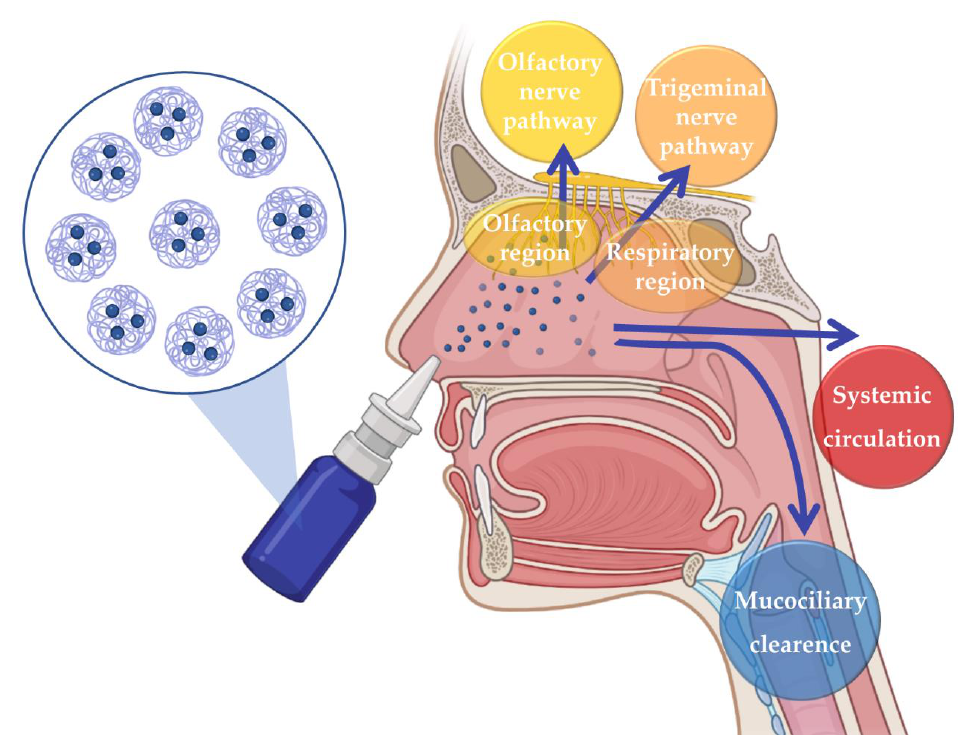
Figure 1. Neuronal and systemic pathways of brain transportation of drugs following intranasal Figure administration.